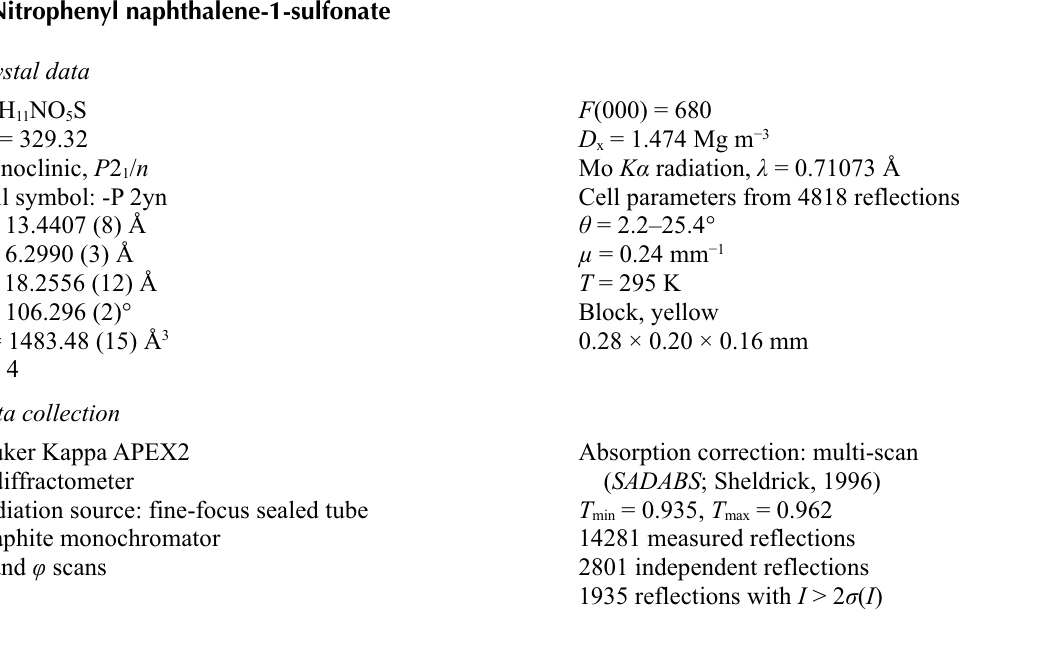
The packing of (I), viewed down the b axis. Hydrogen bonds are shown as dashed lines. H atoms not involved in hydrogen bonding have been